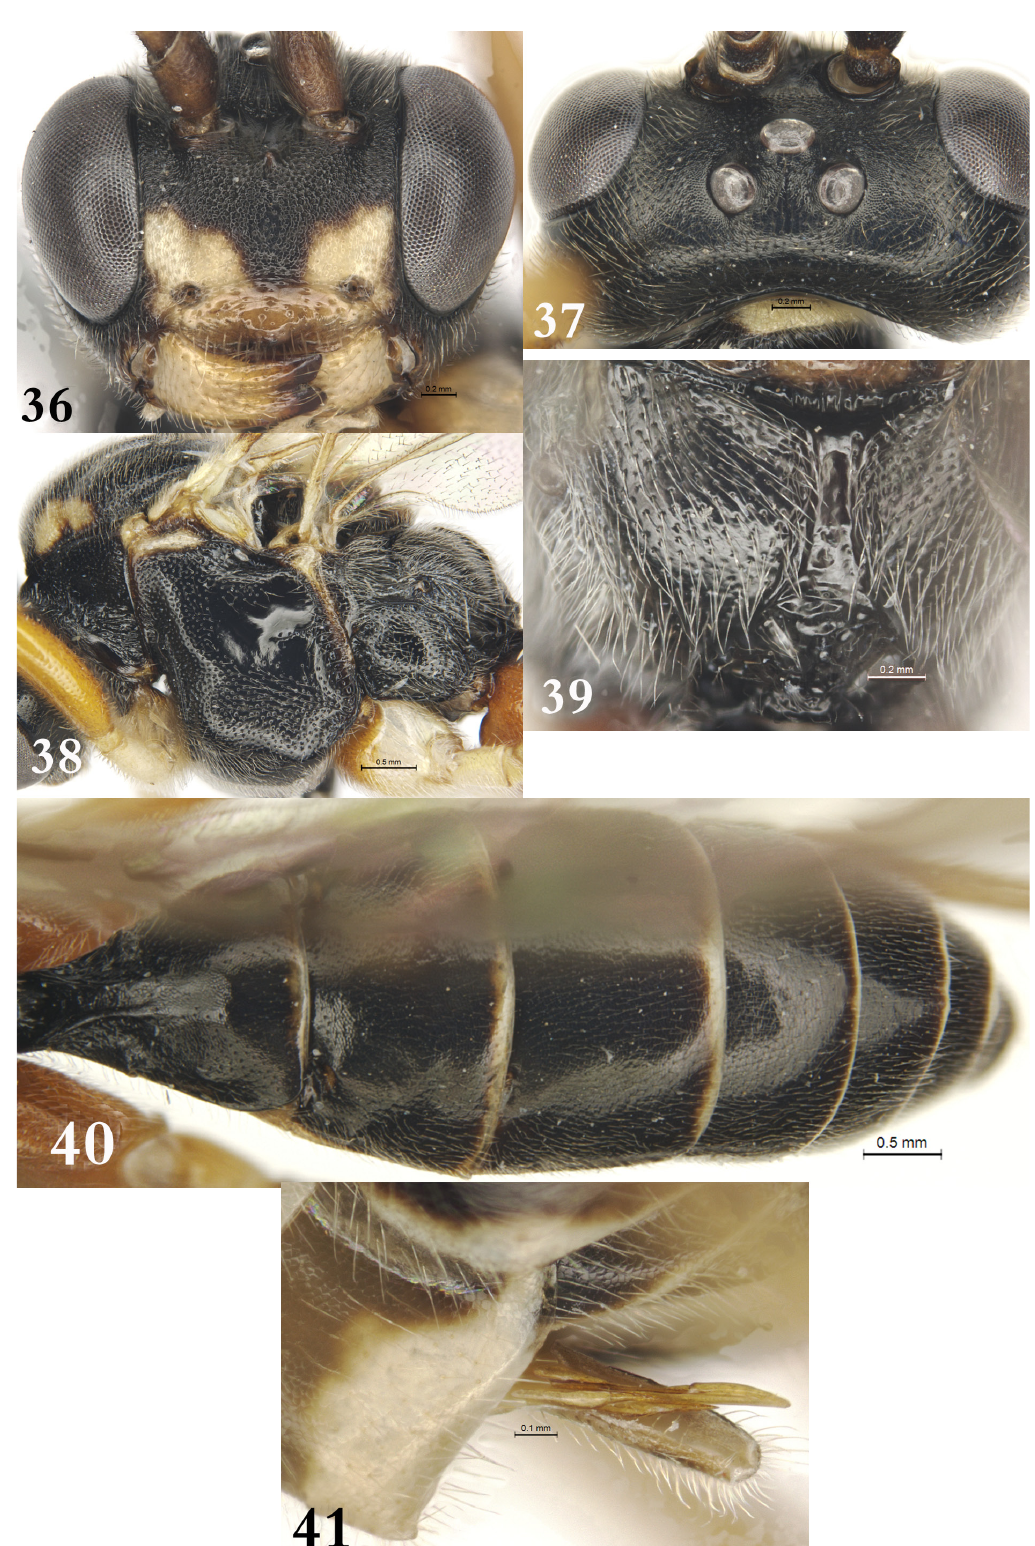
Figs 36–41. Campodorus rasilis Sheng, Sun & Li sp. nov., holotype, ♀ ( GSFGPM). 36 . Head, anterior view. 37 . Head, dorsal view. 38 . Mesosoma, lateral view. 39 . Propodeum. 40 . Metasoma, dorsal view. 41 . Apical portion of metasoma, lateral